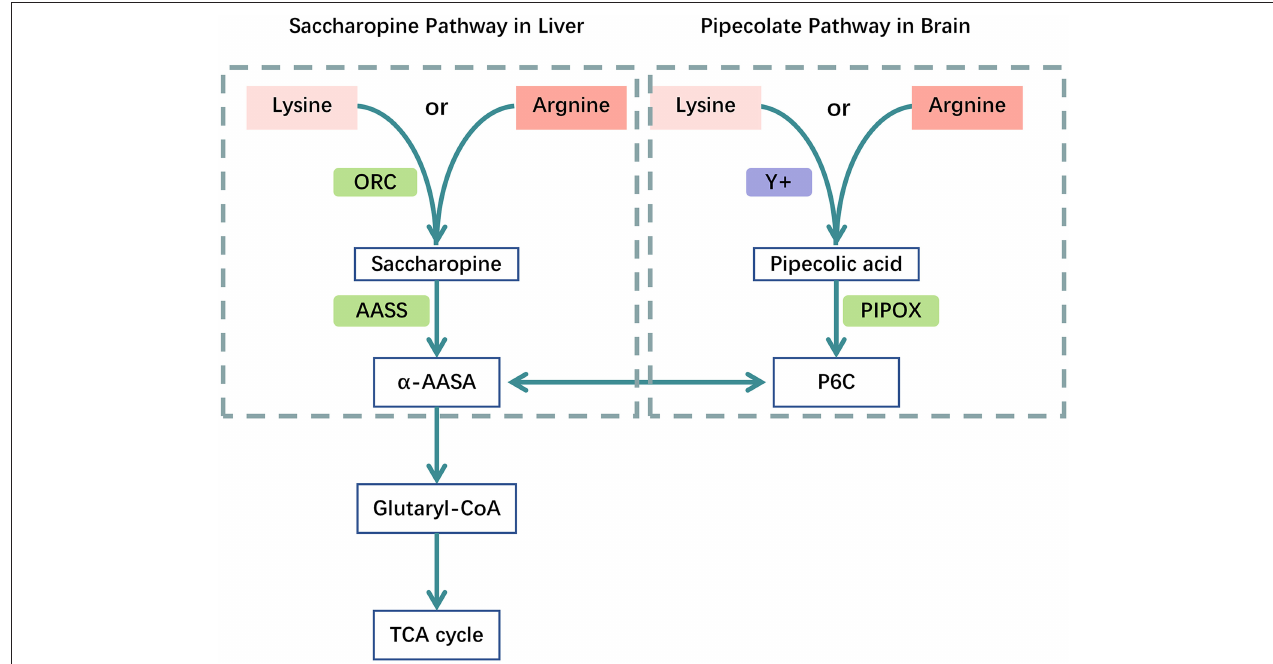
FIGURE 2 | Catabolic pathways of the Lysine metabolism. Competition between L-arginine and L-lysine at the mitochondrial membrane and the blood-brain barrier. Catabolic pathways: (1) the mitochondrial saccharopine pathway is the major route in liver; (2) the peroxisomal pipecolate pathway is the major route in brain, both branches converge in α -AASA and its cyclic equivalent P6C. Acetyl-CoA is the ultimate product of the lysine degradation. human mitochondrial ornithine carriers 1 and 2 (ORC); system y + of the blood–brain barrier (y + ), pipecolate oxidase (PIPOX), AASS, α -aminoadipate semialdehyde synthase (AASS); piperideine-6-carboxylate (P6C); α -aminoadipate semialdehyde ( α -AASA); α -AAA, α -aminoadipate ( α -AAA); tricarboxylic acid-cycle (TCA